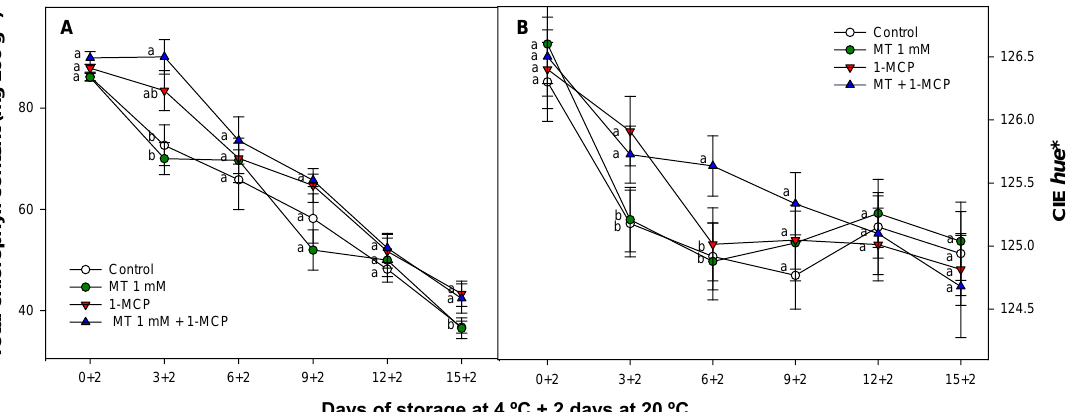
Figure 5. Evolution of total chlorophyll content (mg 100 g − 1 ) ( A ) and CIE hue* ( B ) of ‘Cronos’ zucchini fruit treated with melatonin at 1 mM (MT) or distilled water (Control) with or without 1-MCP during cold storage and after cold storage plus 2 days at 20 °C. Data are the mean ± SE (n = 3). Different lowercase letters show significant differences ( p < 0.05) among treatments for each sampling date.